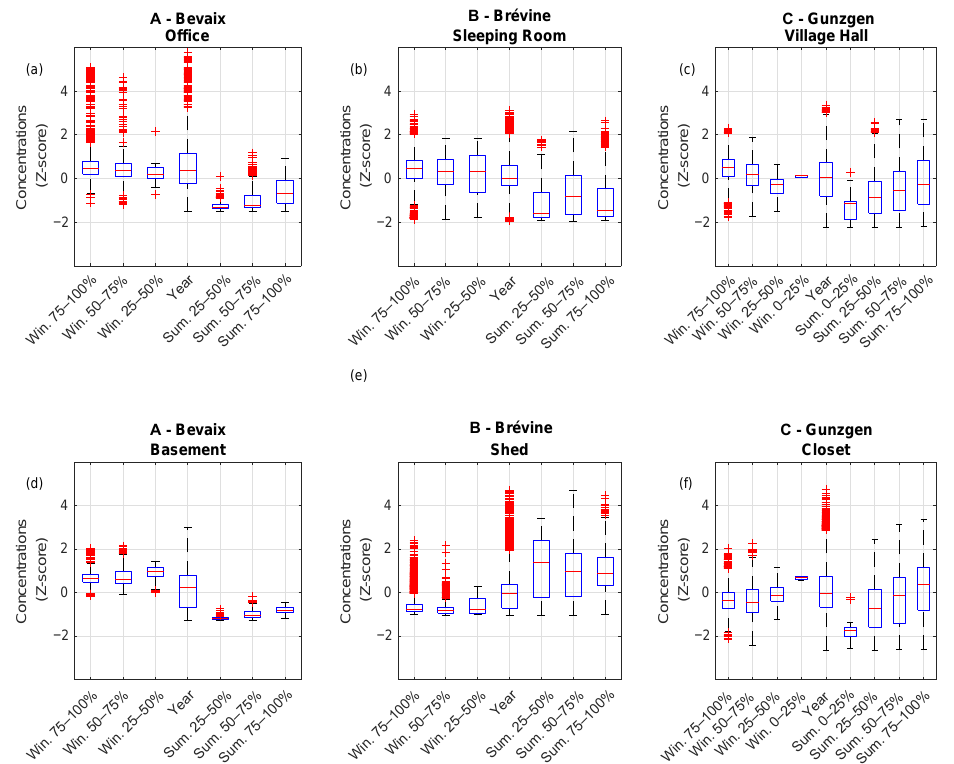
Figure 5. Box-plots synthesizing the impacts of relative humidity on IRC at Bevaix ( a , d ), La Brévine ( b , e ), and Gunzgen ( c , f ). Occupied spaces are shown in ( a – c ) and unoccupied spaces in ( d – f ). Relative humidity ranges are given for both winter and summer. Some of them are missing because they did not